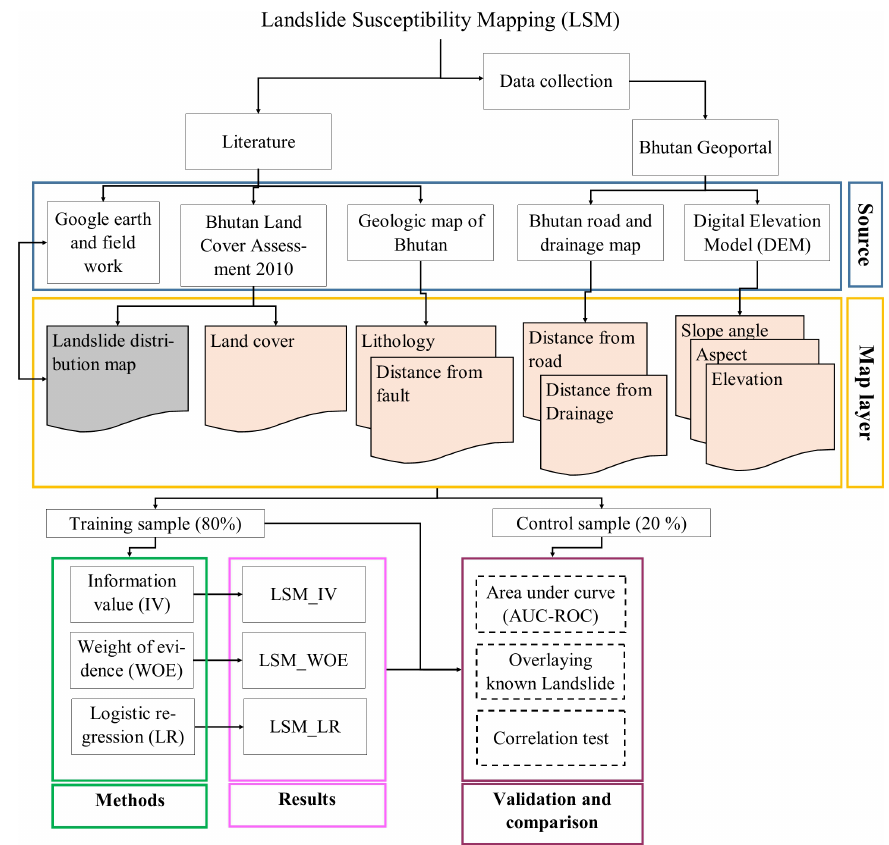
Figure 6. Flowchart showing the methodology of the